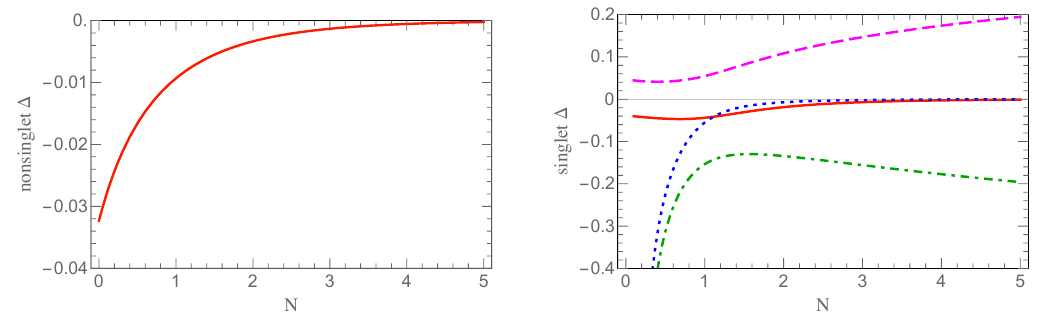
2 (cid:1) (cid:0) (cid:0)